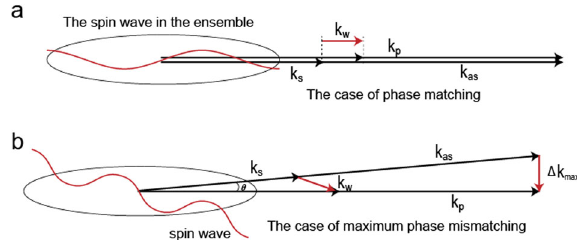
Fig. 6 The phase mismatching in the read out of W state. a The case of phase matching with Δ k = 0. b The case of the maximum phase mismatching with Δ k = 2 k p − k s − k as